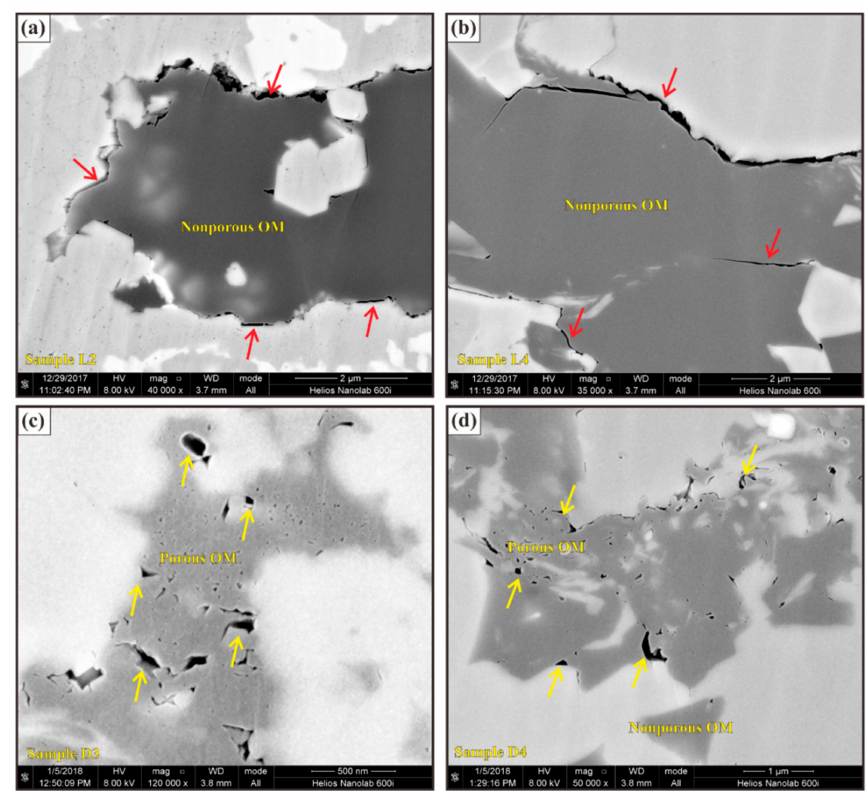
Figure 7. SEM photomicrograph images of OM-hosted pores in Lujiaping deformed shales. Natural thermally controlled fractures are indicated with red arrows whereas the OM pores are indicated with yellow arrows. ( a ) SEM image showing shrinkage crack pores within OM of sample L2; ( b ) SEM image showing shrinkage crack pores within OM of sample L4; ( c ) SEM image showing OM-hosted pores within sample D3; ( d ) SEM image showing OM-hosted pores within sample